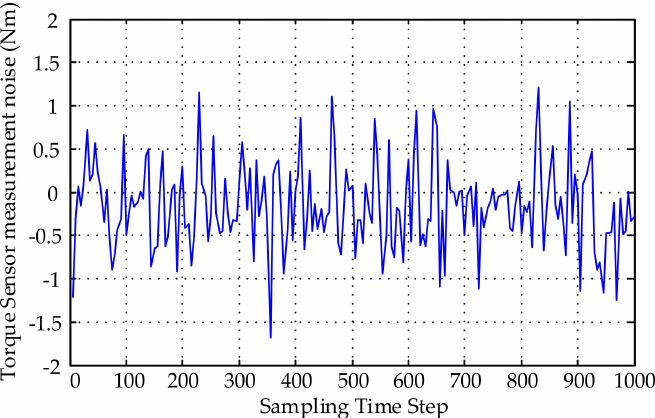
Figure 5. The random measurement noise of the torque sensor (sampling time is 1 ms).